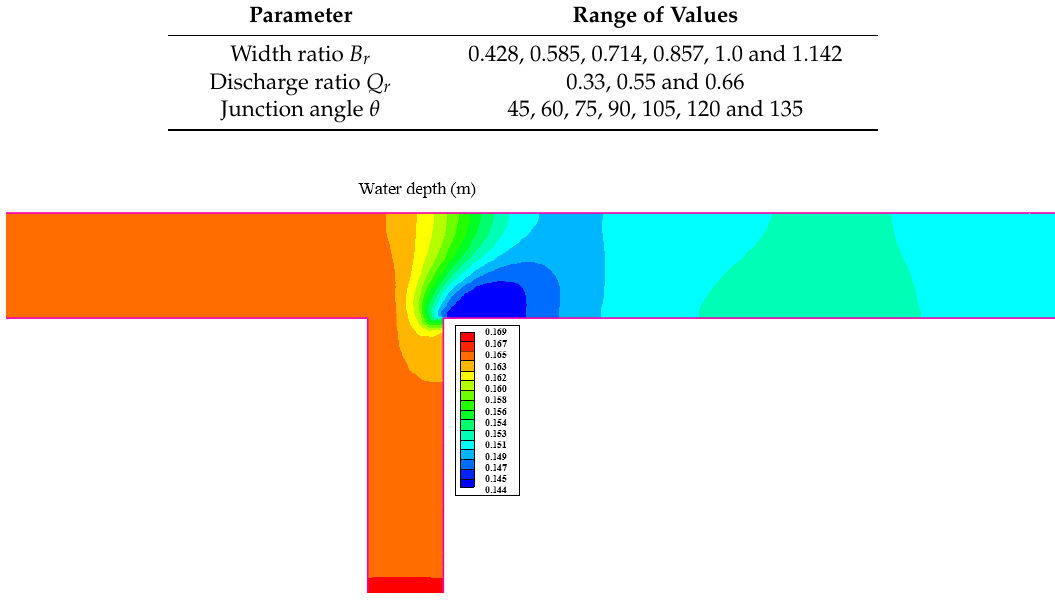
Figure 10. Distribution of depth averaged velocity for Run 2. Figure 10 shows a separation zone occurred immediately downstream of the tributary mouth and the maximum flow rate was established in the mid-channel. The longitudinal velocity of flow was greatly reduced, and backward flow occurred in the separation zone; hence, in this section, horizontal vortexes were formed leading to sedimentation. Moreover, the transfer of momentum to the middle of the main channel and even to the opposite bank increased the shear stress in bed and